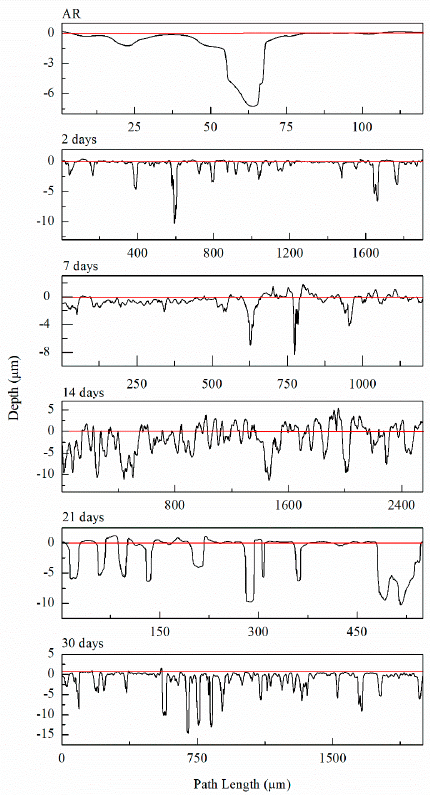
Figure 8. Line profiles of the deepest pits observed from IFM imaging for AA5083 as-received (AR) and sensitized at 150 °C for 2 days, 7 days, 14 days, 21 days and 30 days.